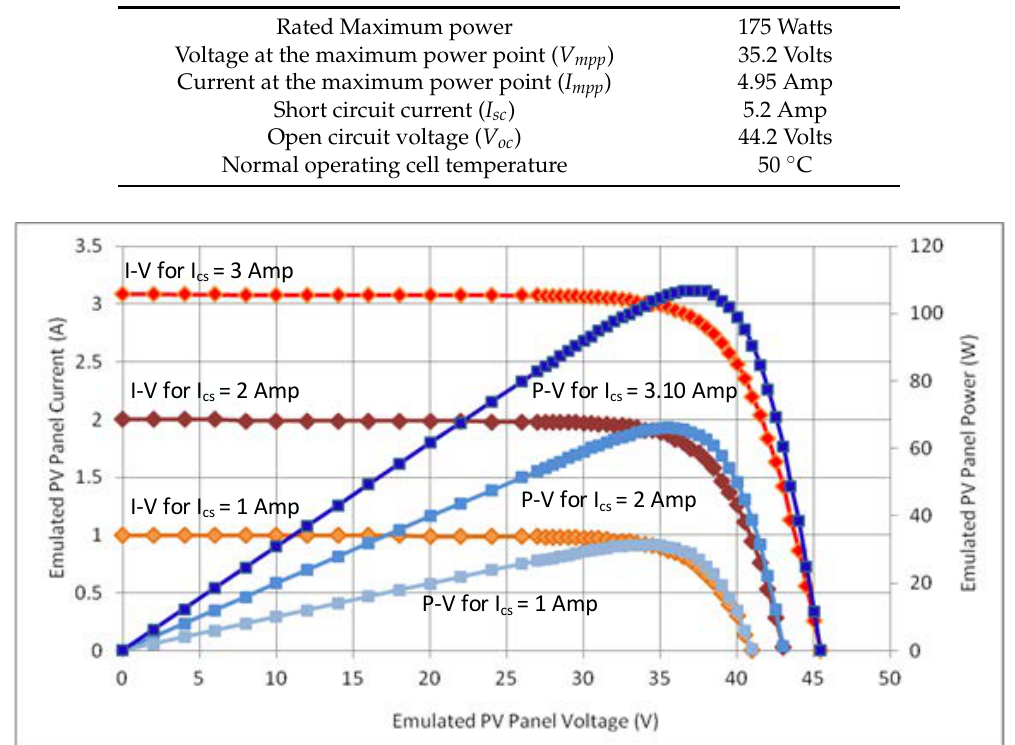
Figure 13. Measured electrical characteristics of the emulated PV source with excitement different currents.